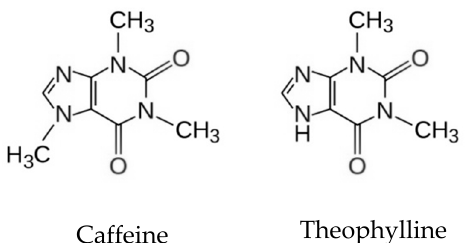
Figure 2. Chemical structure of caffeine and theophylline.